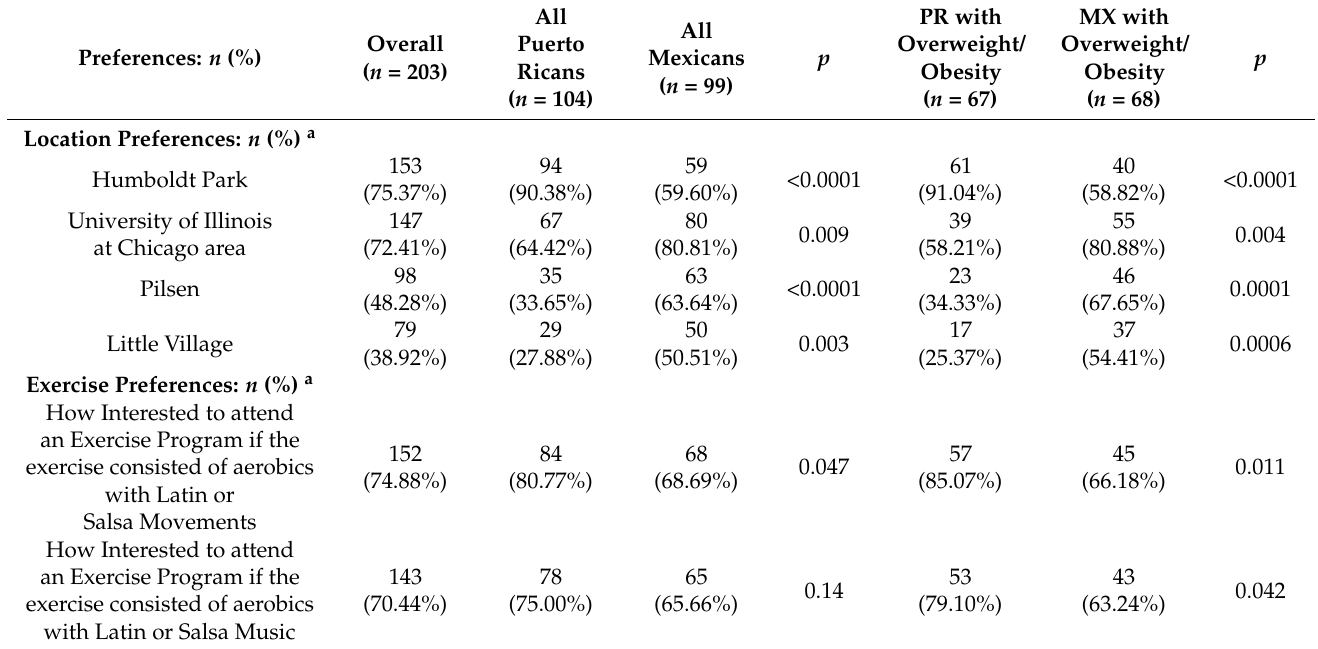
Table 2. Preferences for the Location of the Intervention and Exercise Preferences among All Partici- pants and among Participants with Overweight or